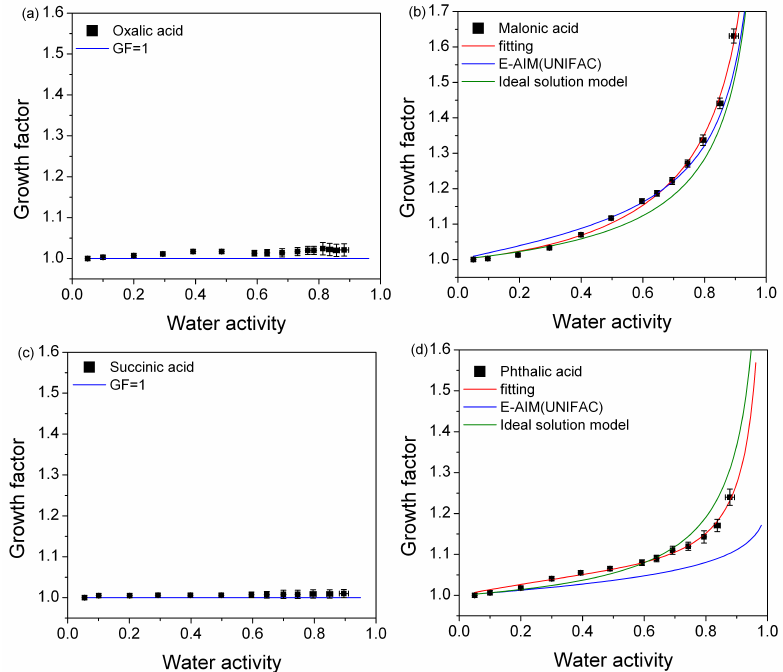
Figure 2. Hygroscopic growth factors of (a) oxalic acid, (b) malonic acid, (c) succinic acid, and (d) phthalic acid particles as a function of water activity. Initial particle diameter is about 100nm. For malonic acid and phthalic acid, the fit to the measurements with Eq. (2) is shown. Predictions from the E-AIM (UNIFAC) and ideal solution model are also included. The uncertainty in our measured growth factors is within